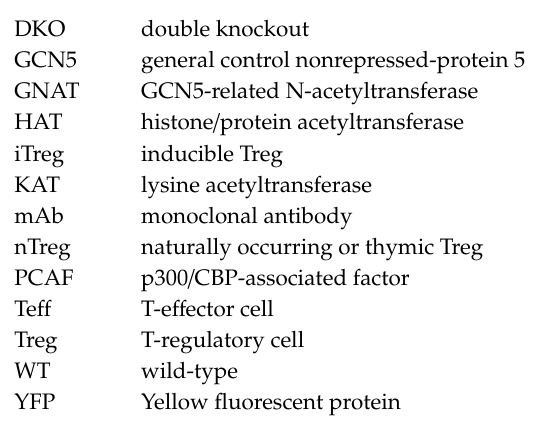
Figure S1: T cell deletion of GCN5 in Foxp3 + Tregs, Figure S2: T cell deletion of GCN5 in all T cells (using CD4 cre ), Figure S3: T cell deletion of GCN5, using CD4 cre , did not a ff ect the level of T cell activation under resting conditions, Figure S4: T cell deletion of GCN5 impaired CD4 + CD25 − Te ff proliferation, Figure S5: GCN5 deletion impairs CD4 + T cell production of IL-2, and in WT cells GCN5 promotes acetylation of p65 / NF κ B and histone-H3 and is recruited to the IL-2 promoter during T cell activation, Figure S6: T cell deletion of GCN5 promotes cardiac allograft survival, Figure S7: Cumulative data (mean ± SD) from 3 experiments and relating to Figure 2F,G and Figure 3A, Figure S8: PCAF deletion did not impair IFN- γ production by TH1 cells, Figure S9: Cumulative date (mean ± SD) from 3 experiments and relating to Figure 6E,F, Figure S10: Cumulative date (mean ± SD) from 3 experiments and relating to Figure 6G,H, Figure S11: Cumulative date (mean ± SD) from 3 experiments and relating to Figure